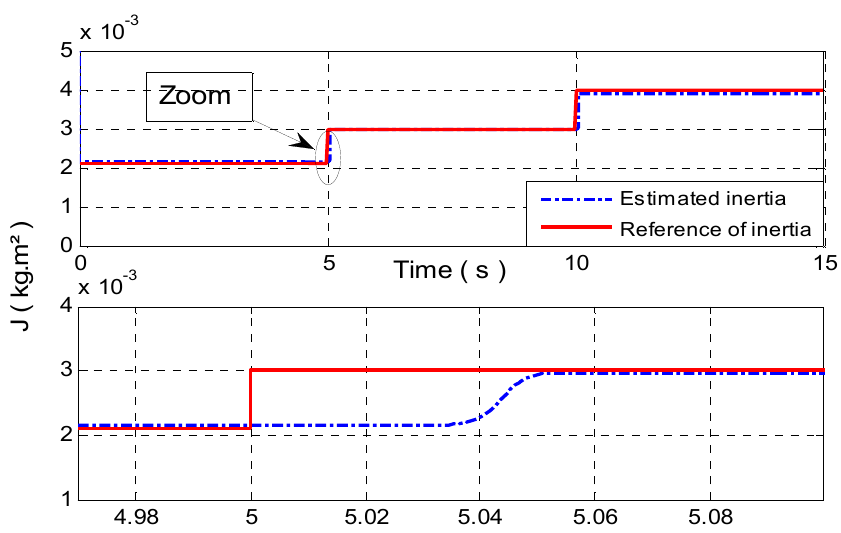
Figure 5. The estimated inertia and its reference value with zoom.